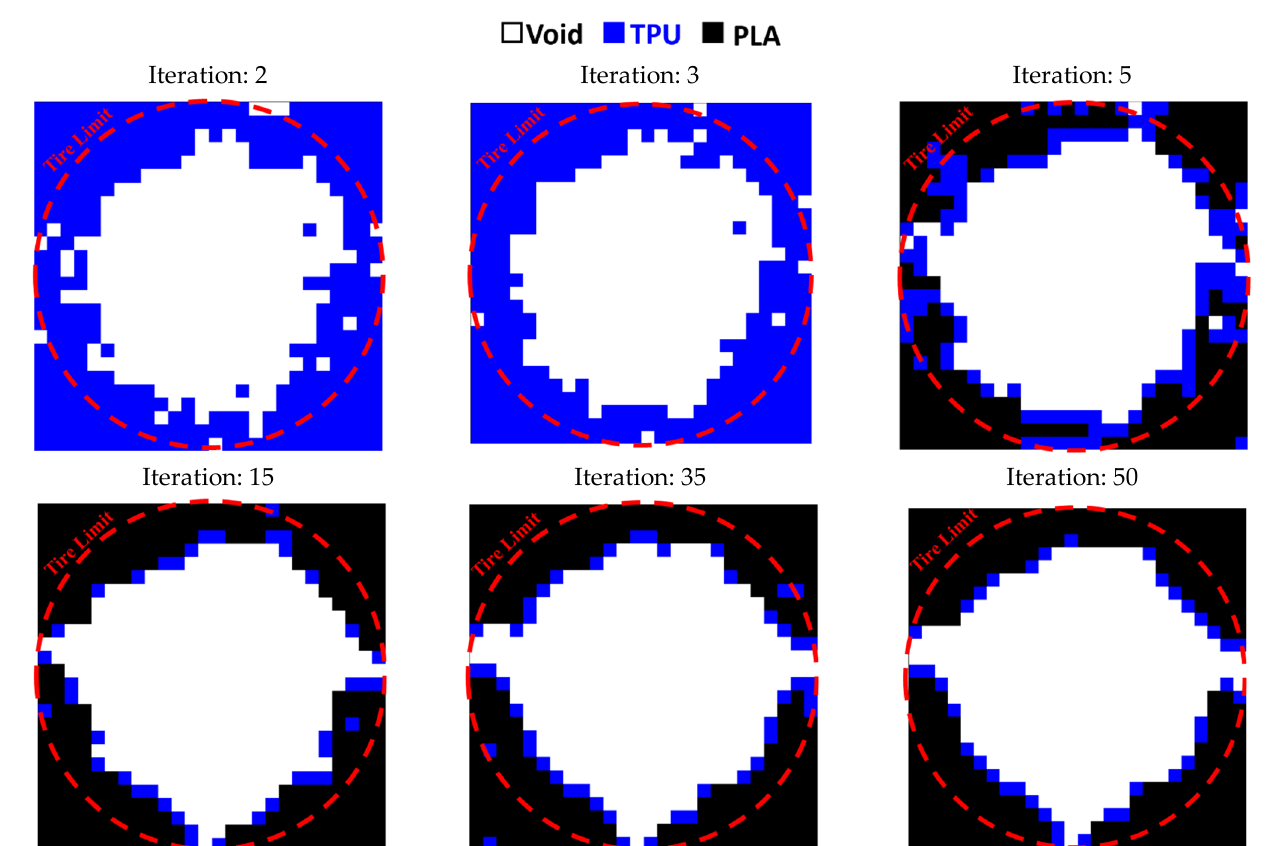
Figure 17. The results of the optimal distribution of materials in the tire.